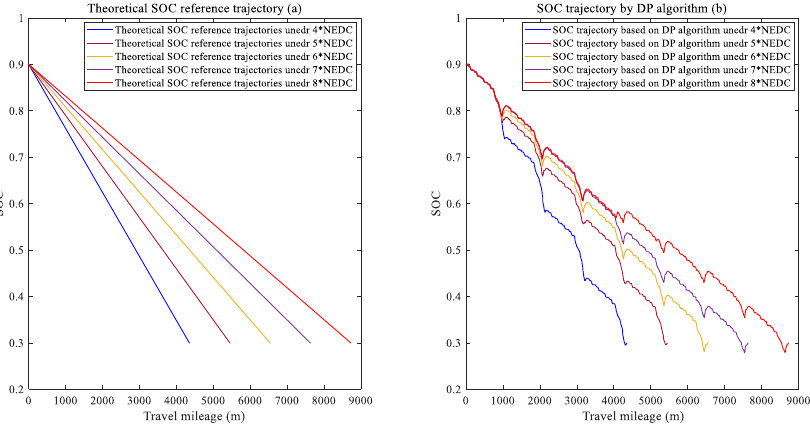
Figure 6. Schematic of SOC planning based on travel mileage. ( a ) Theoretical SOC reference trajectory; ( b ) SOC trajectory based on DP algorithm.